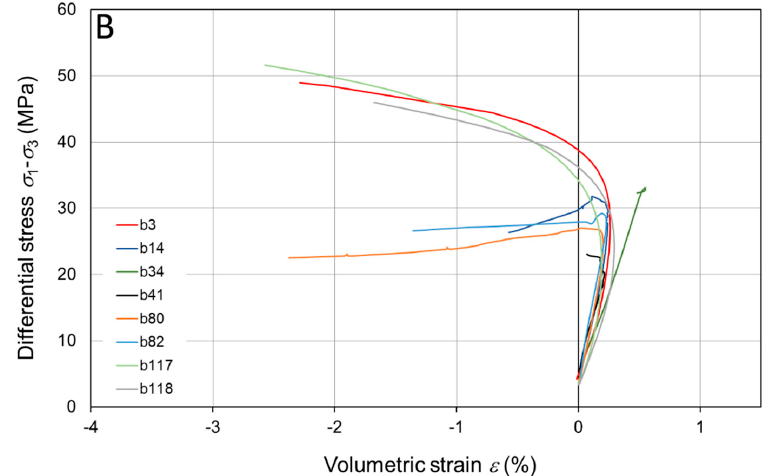
Figure 13. Stress–strain characteristics of the Brown Zuber unit samples in the tests at a constant strain rate. ( A )—axial strain; ( B )—volumetric strain (according to [57]).